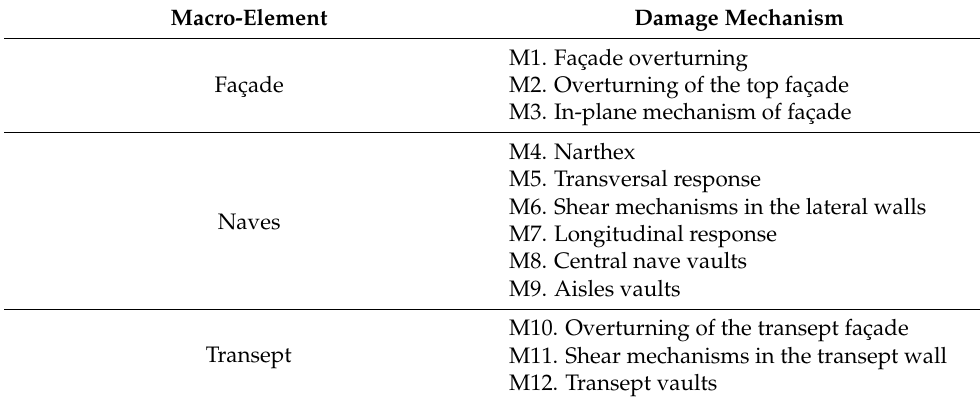
Table 1. Damage mechanisms and macro-element of masonry churches according to Italian